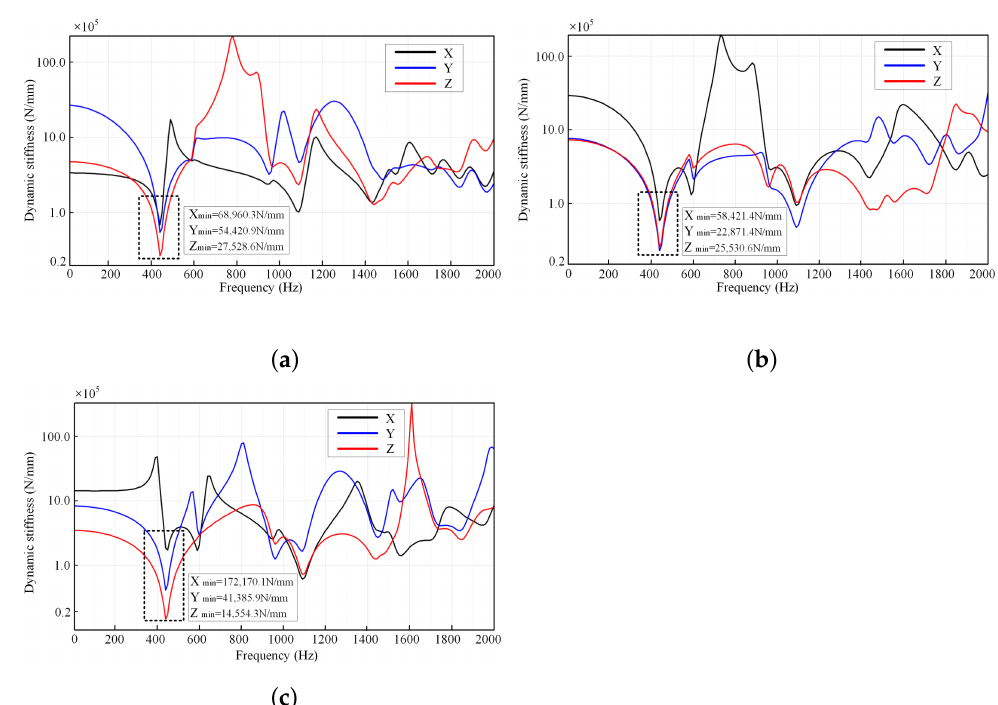
Figure 17. The dynamic stiffness simulation of the optimized gearbox housing. ( a ) Stiffness curves of the output end of front gearbox housing after optimization. ( b ) Stiffness curves of the intermediate end of rear gearbox housing after optimization. ( c ) Stiffness curves of the output end of rear gearbox housing after optimization.